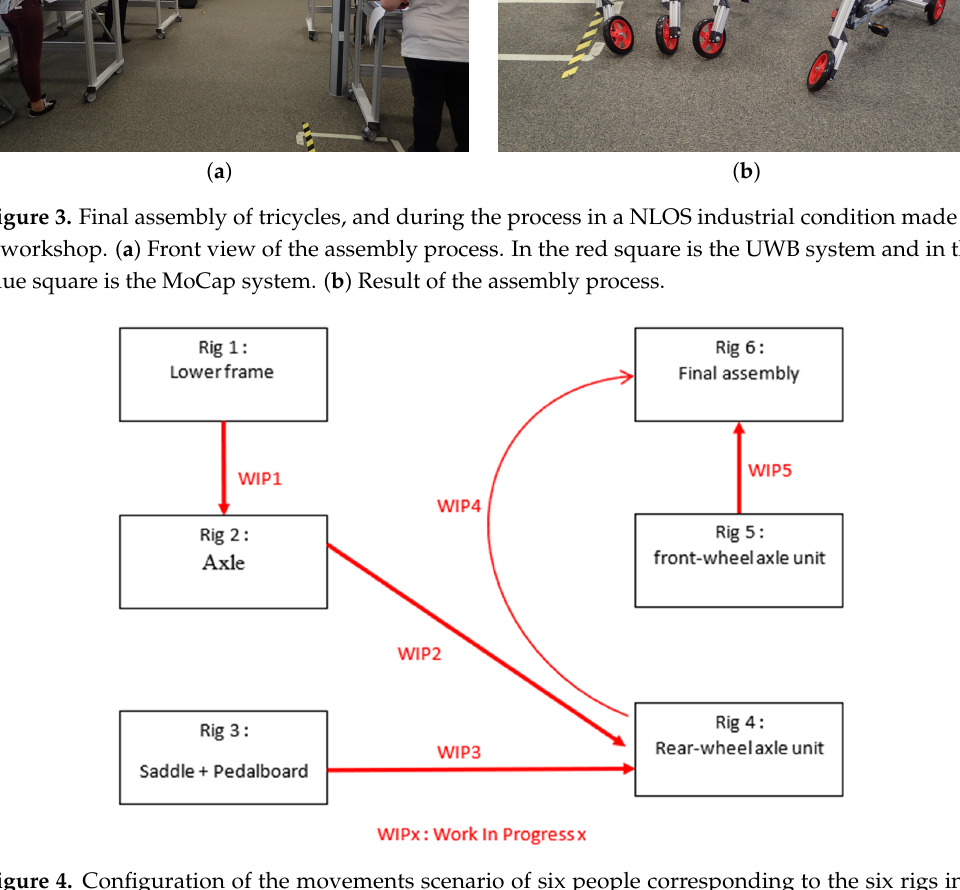
Figure 4. Configuration of the movements scenario of six people corresponding to the six rigs in a NLOS condition made in a